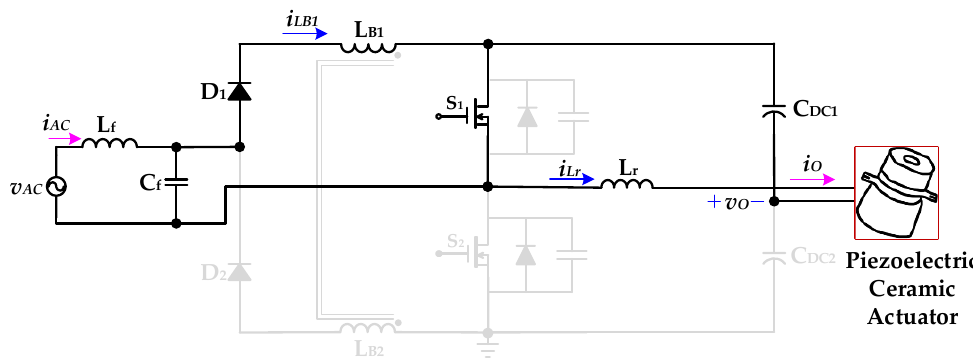
Figure 6. Operation Mode 1 of the proposed drive circuit for the piezoelectric ceramic actuator.